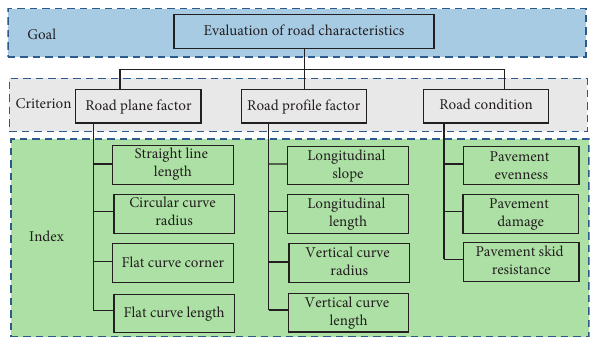
Figure 3: The structure of road characteristics evaluation index Table 1: Standard degree of the nine-scale method.